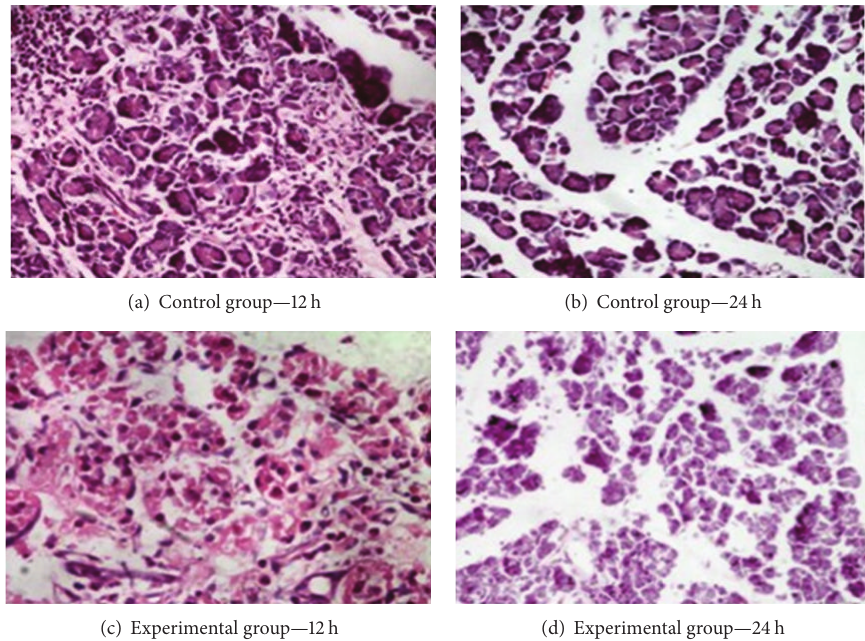
Figure 1: Pancreatic tissue HE staining.